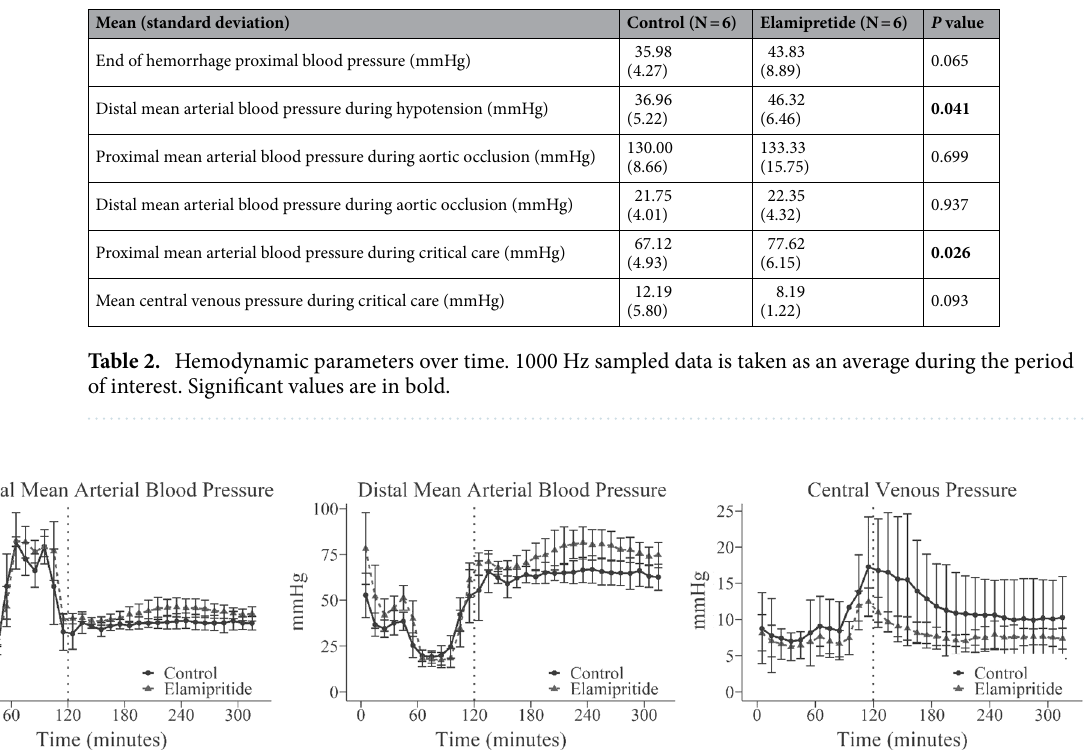
Mean (standard deviation)